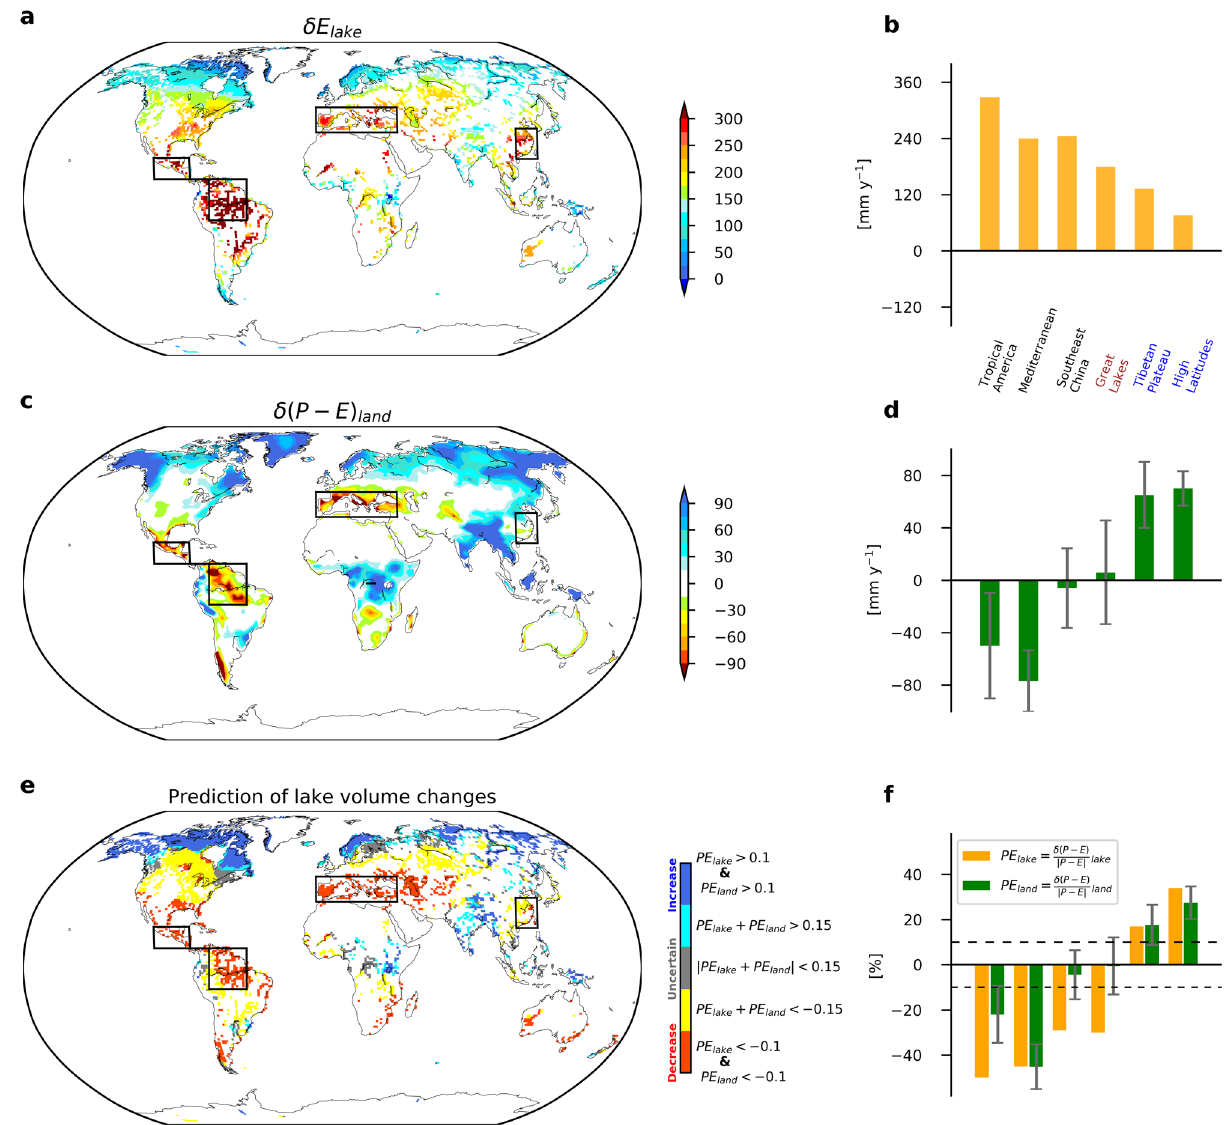
Fig. 1 Spatially coupled future changes in lake evaporation and hydroclimate and the implication on regional lake volume changes. a Spatial pattern of future changes in lake evaporation based on the CLM projection (under RCP8.5; 2071 – 2100 minus 1971 – 2000). b Future changes in lake evaporation averaged over tropical America (12°S – 9°N; 70°W – 50°W and 10°N – 20°N; 105°W-85°W), the Mediterranean (35°N – 47°N; 10°W – 40°E), Southeast China (20°N – 35°N; 110°E – 125°E), Great Lakes (41°N – 49°N; 92°W – 77°W), Tibetan Plateau (28°N – 36°N; 75°E – 95°E), and high latitudes (poleward of 60°N). c Spatial pattern of future changes in the land P-E based on the mean projection of 22 CMIP5 models. d Future changes in the land P-E averaged over the six regions. The mean and standard deviation of the ensemble projection are shown in the bar plot. e Qualitative prediction of future lake volume changes based on P-E ’ s over land and lake. f Fraction changes in the lake and land P-E ’ s averaged over the six regions. The regions with a drier future hydroclimate, i.e., tropical America, the Mediterranean and Southeast China, are denoted by the black